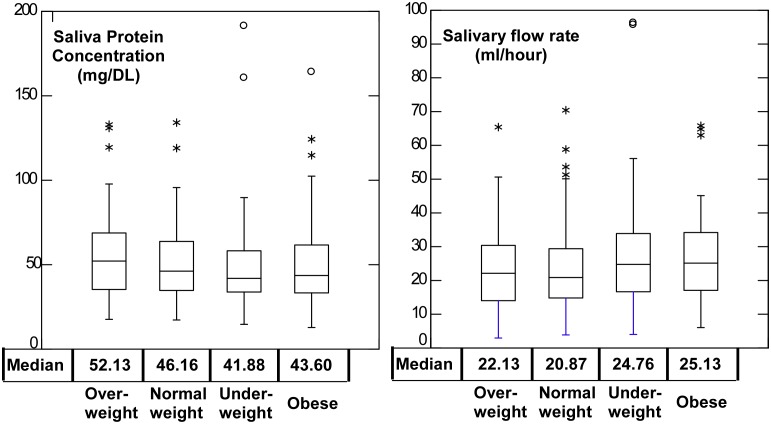
Salivary protein concentration and salivary flow rate of children by body weight category.Neither protein content nor salivary flow rate differed significantly in this subset of 213 samples between children in each body weight category.